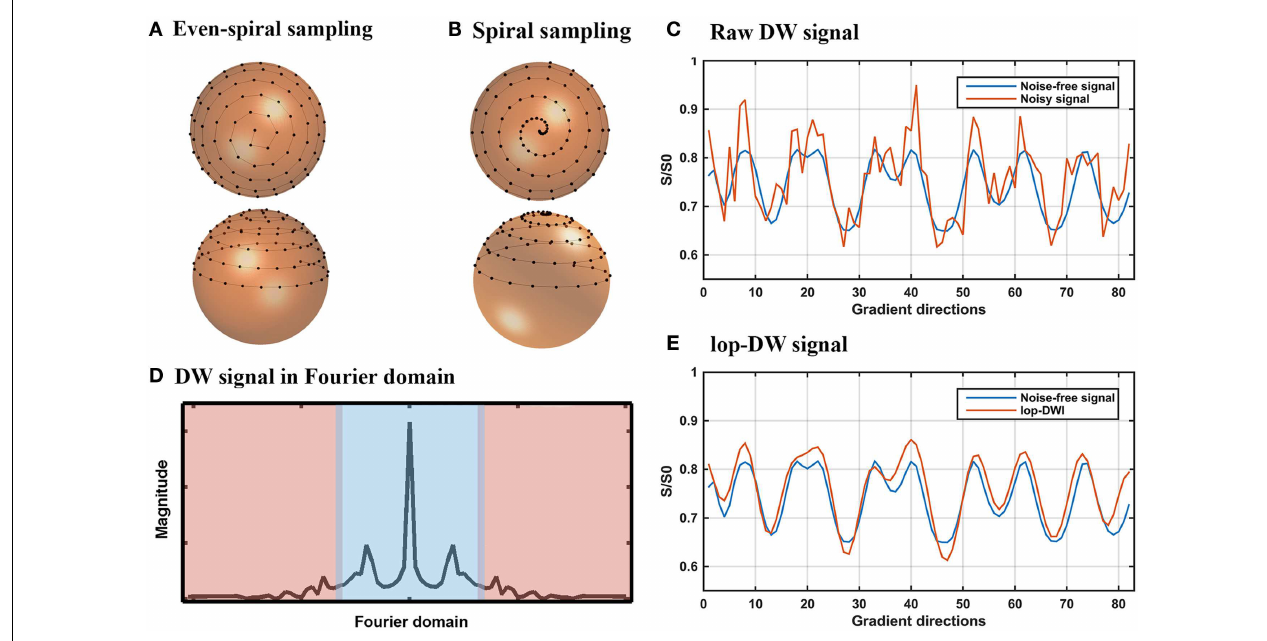
direction domain, (D) a representative view of diffusion-weighted signal in frequency domains, where blue area represents low-frequency part of the diffusion-weighted signal, (E) noise-free and filtered diffusion-weighted signals of a given voxel of the phantom in the gradient direction